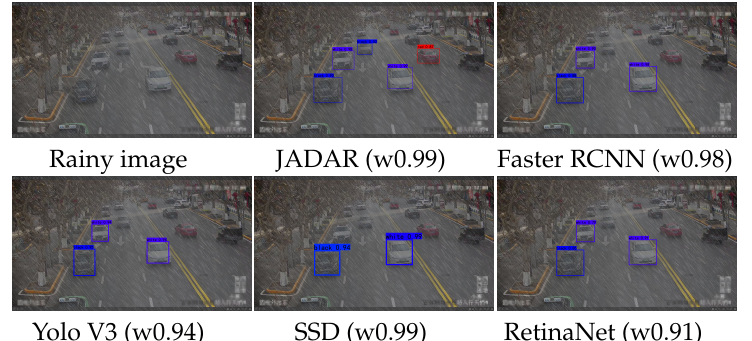
Figure 7. Example 1 of test results of JADAR and object detection methods on the Rain Vehicle Color-24 test set.